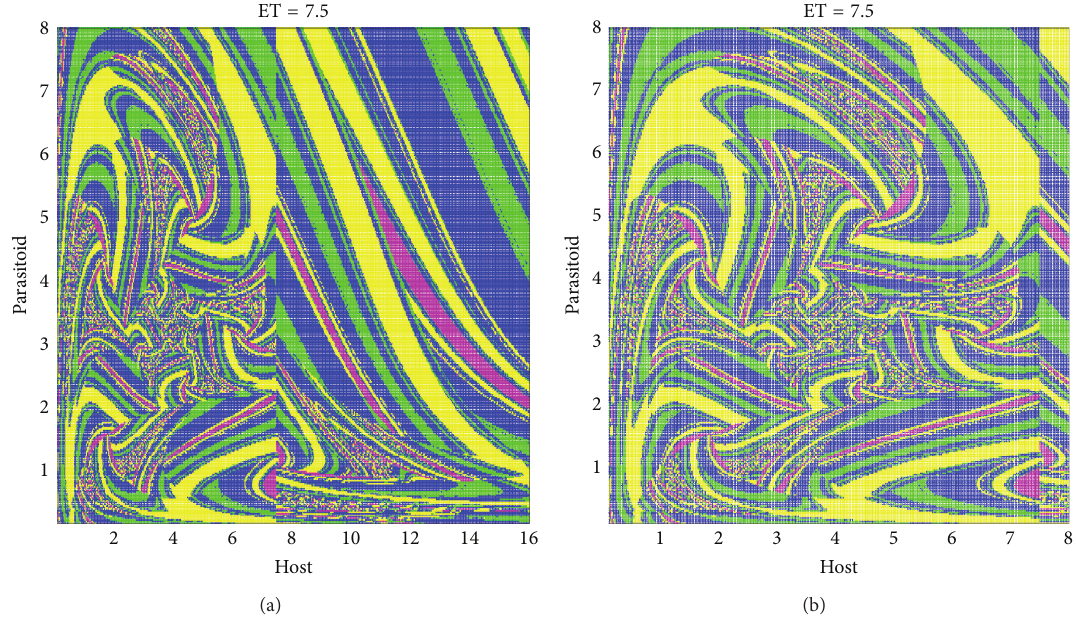
Figure 4: Basins of attraction of four coexisting attractors of system (3). The horizontal axis and vertical axis are the host and parasitoid initial values 𝐻 0 ,𝑃 0 , respectively. (a) Basin of attraction of four periodic solutions shown in Figure 3, where the intervals of initial values are ≤ 16, 0 ≤ 𝑃 ≤ 8 ; (b) an enlargement of (a) with range 0 ≤ 𝐻 ≤ 8 , 0 ≤ 𝑃 ≤ 8 . The other parameters are fixed the same as in 0 ≤ 𝐻 0 0 0 0 Figure 3. The magenta region represents Figures 3(a) and 3(b) attractor, the blue region represents Figures 3(c) and 3(d) attractor, the green region represents Figures 3(e) and 3(f) attractor, and the yellow region represents Figures 3(g) and 3(h) attractor.